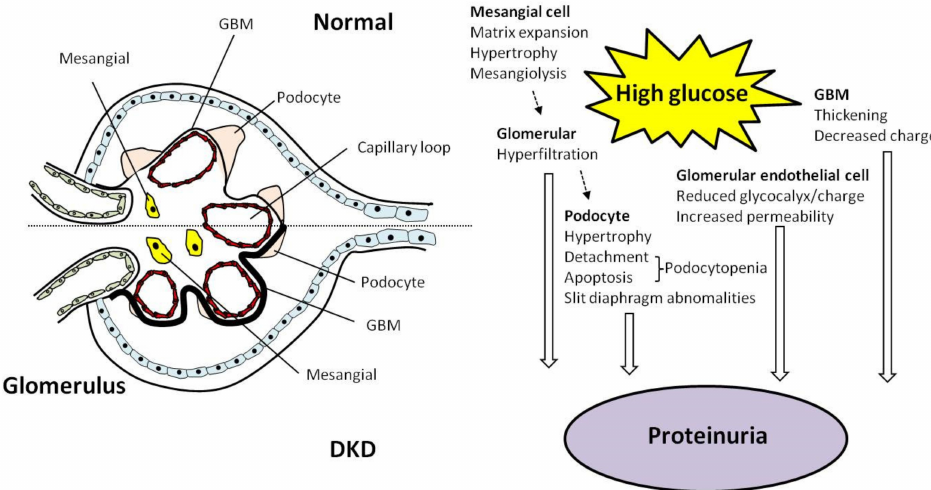
Figure 1. Characteristic glomerular changes and mechanisms of proteinuria in diabetic kidney disease. Characteristic glomerular changes in diabetic kidney disease (DKD) include glomerular basement membrane (GBM) thickening and mesangial expansion (due to increased mesangial matrix and increased mesangial cell size caused by hypertrophy). These changes are driven by hyperglycemia, and can ultimately lead to proteinuria if left unaddressed. Dashed arrows indicate mesangial expansion leading to glomerular